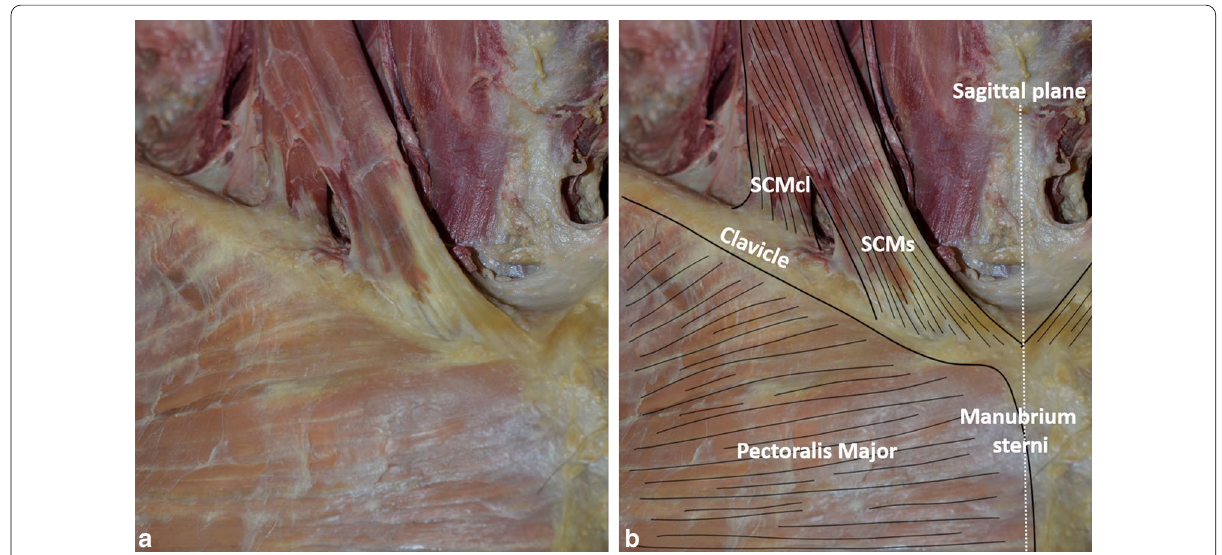
Fig. 1 Anterior view of the right base of the neck and upper torso after removal of skin and subcutaneous tissue without ( a ) and with ( b ) annotations. SCMs: sternal tendon of the sternocleidomastoid muscle; SCMcl: clavicular tendon of the sternocleidomastoid